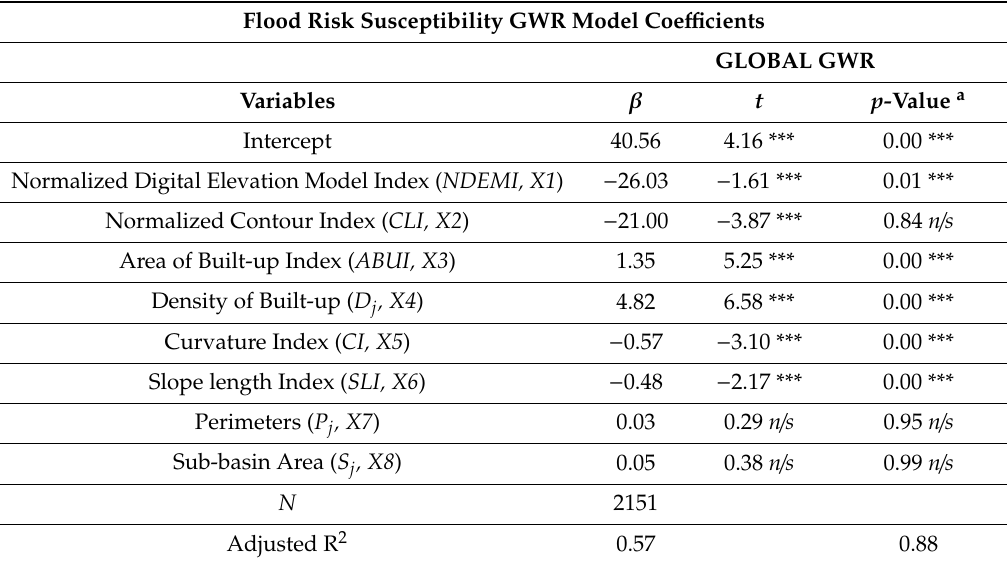
Table 5. Summary results of the flood risk susceptibility FRS-GWR model.